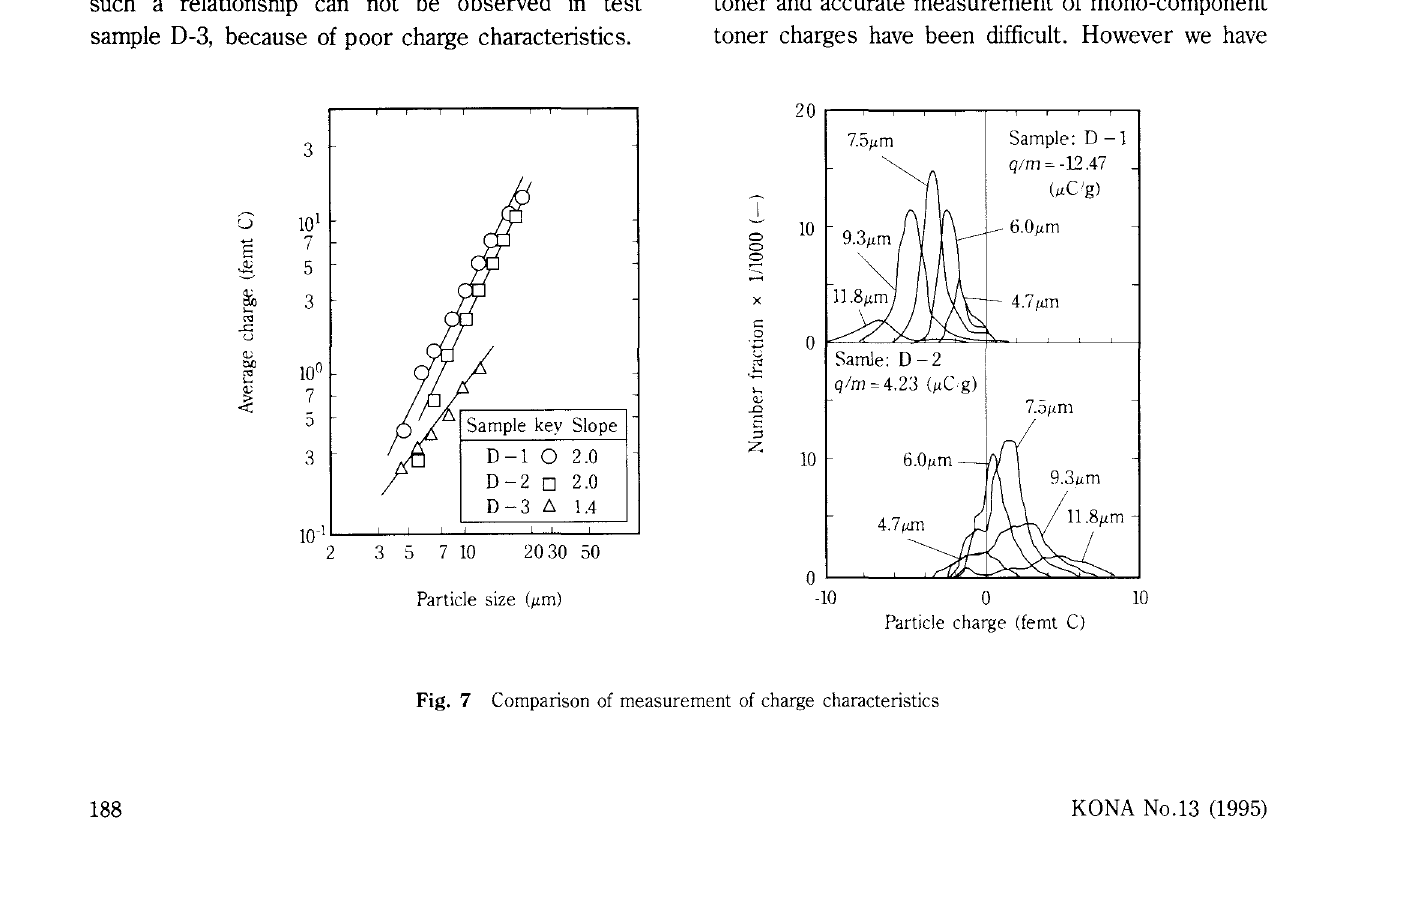
Fig. 7 Comparison of measurement of charge